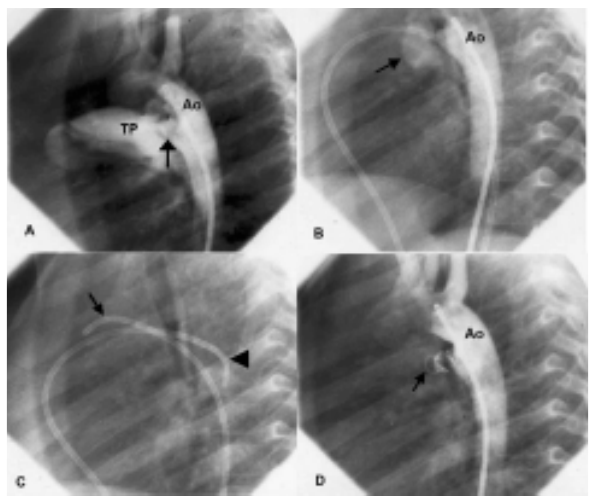
Fig. 5 - A) Aortogram showing type-A arterial duct (arrow). B) Judkin catheter used for the anterograde approach of the right coronary artery and a second aortogram showing a significant reduction in the flow of contrast by the arterial duct (arrow). C) Definitive occlusion with 2 coils using retrograde (arrow) and anterograde (arrowhead) approaches. D) Aortogram 20 minutes after release of two coils showing complete occlusion of the arterial duct (arrow). TP = Pulmonary branch. Ao =